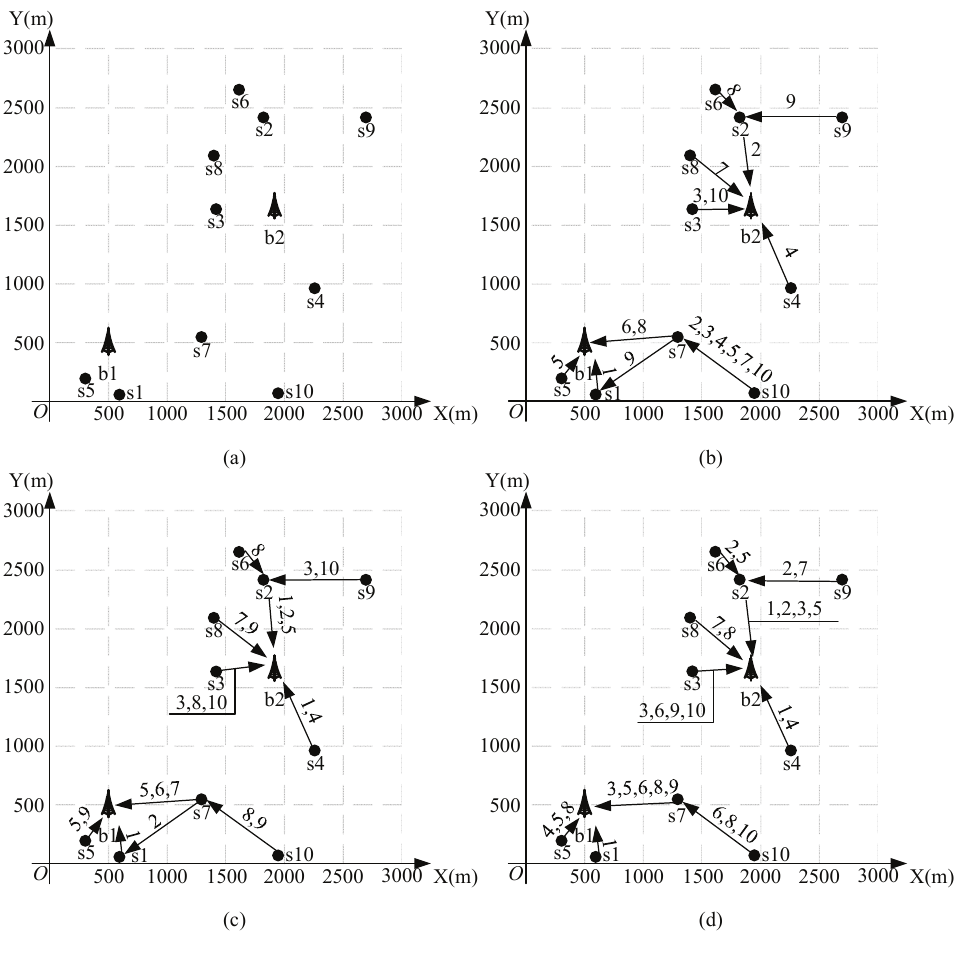
Figure 7. The 10-node, 2-base-station network and schemes in the three different techniques ( a ) The 10-node 2-base station wireless network. ( b ) Routing and time slot allocating scheme for interference avoidance. ( c ) Routing and time slot allocating scheme for SIC-only. ( d ) Routing and time slot allocating scheme for